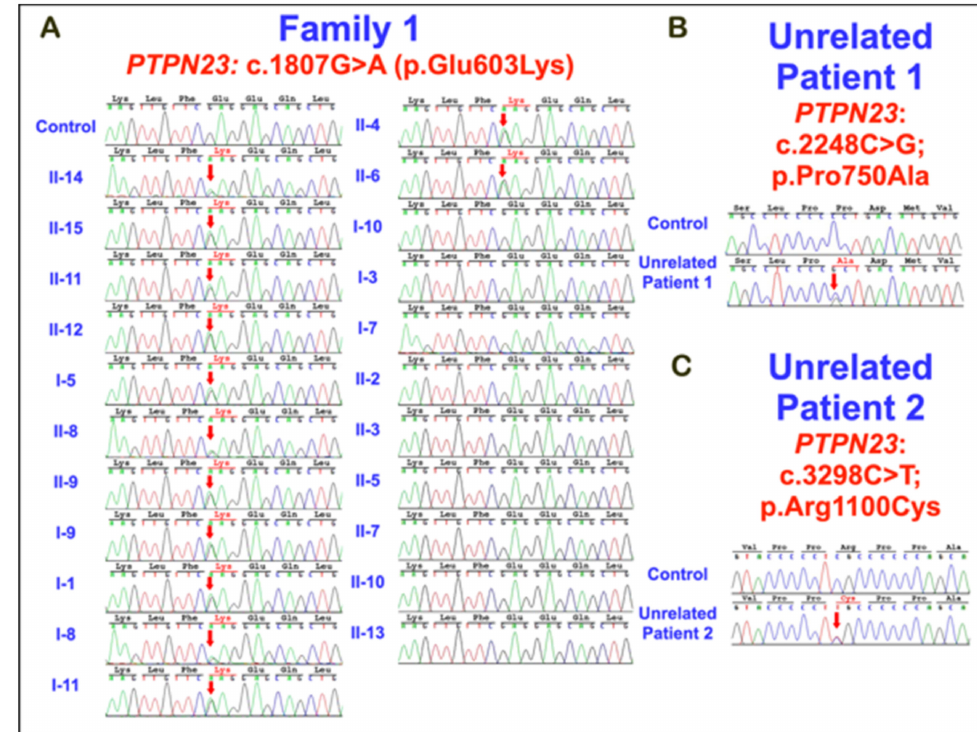
Figure 3. Chromatograms of the heterozygous missense ( A ) c.1807G>A; p.Glu603Lys, ( B ) c.2248C>G; p.Pro750Ala, and ( C ) c.3298C>T; p.Arg1100Cys mutations in PTPN23 gene in family 1, unrelated patient 1 and unrelated patient 2,